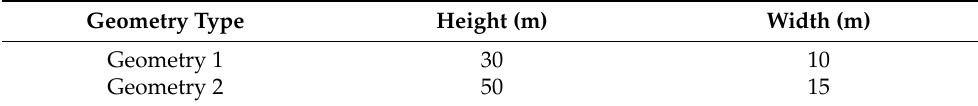
Table 5. The list of the examined sets of the open stope’s geometrical